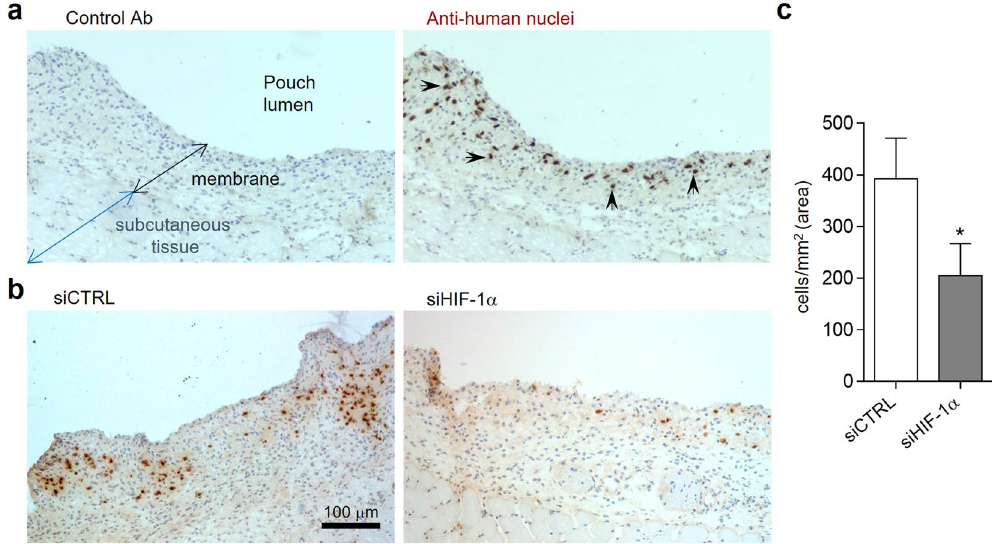
Figure 4. Viability of implanted RASF in the air pouch after HIF-1 α siRNA injection. ( a ) IHC immunoperoxidase labelling with isotype control (left) or anti-human nuclei (right), identifying RASF in the air pouch wall at day 7 after implant. Examples of positive human nuclei marked by arrows. ( b ) Representative human nuclei staining in sections from siCTRL and siHIF-1 α injected air pouches ( c ) Quantitative analysis of human cell nuclei per area (mm 2 ) in siCTRL and siHIF-1 α air pouch membranes. Mean ± SEM data are of 9 mice per group ( * p = 0.04, Mann-Whitney